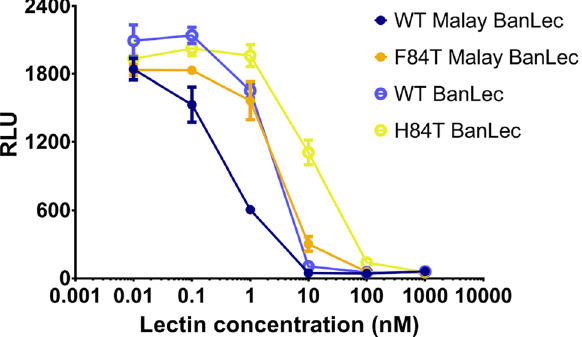
Figure 5. F84T retains antiviral activity against HIV. TZM-bl cells were pre-treated with WT or F84T Malay BanLec, or WT or H84T BanLec and exposed to HIV BaL for 2 d. To assess levels of infection, luciferase activity was measured. Data are representative of two independent experiments. Error bars represent the SEM. The figure was generated using GraphPad Prism 7 (https ://www.graph pad.com/scien tific -softw are/prism /) and Adobe Illustrator, version 22.1.0 (https ://www.adobe .com/produ cts/illus trato r.html).